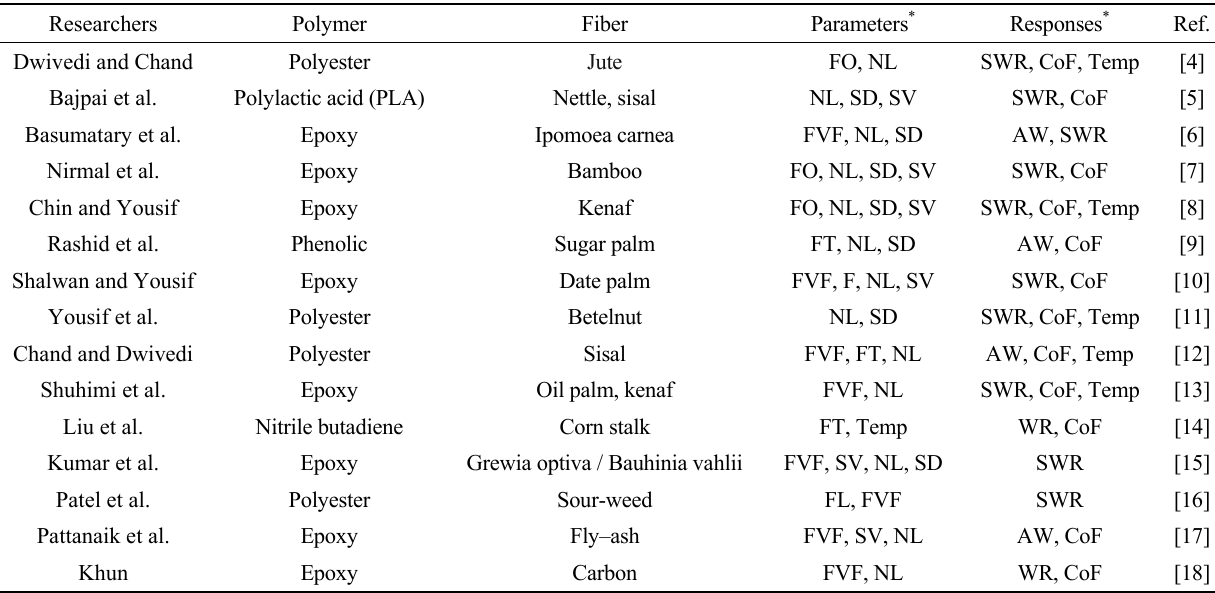
Table 3 Tribology study of fiber reinforced